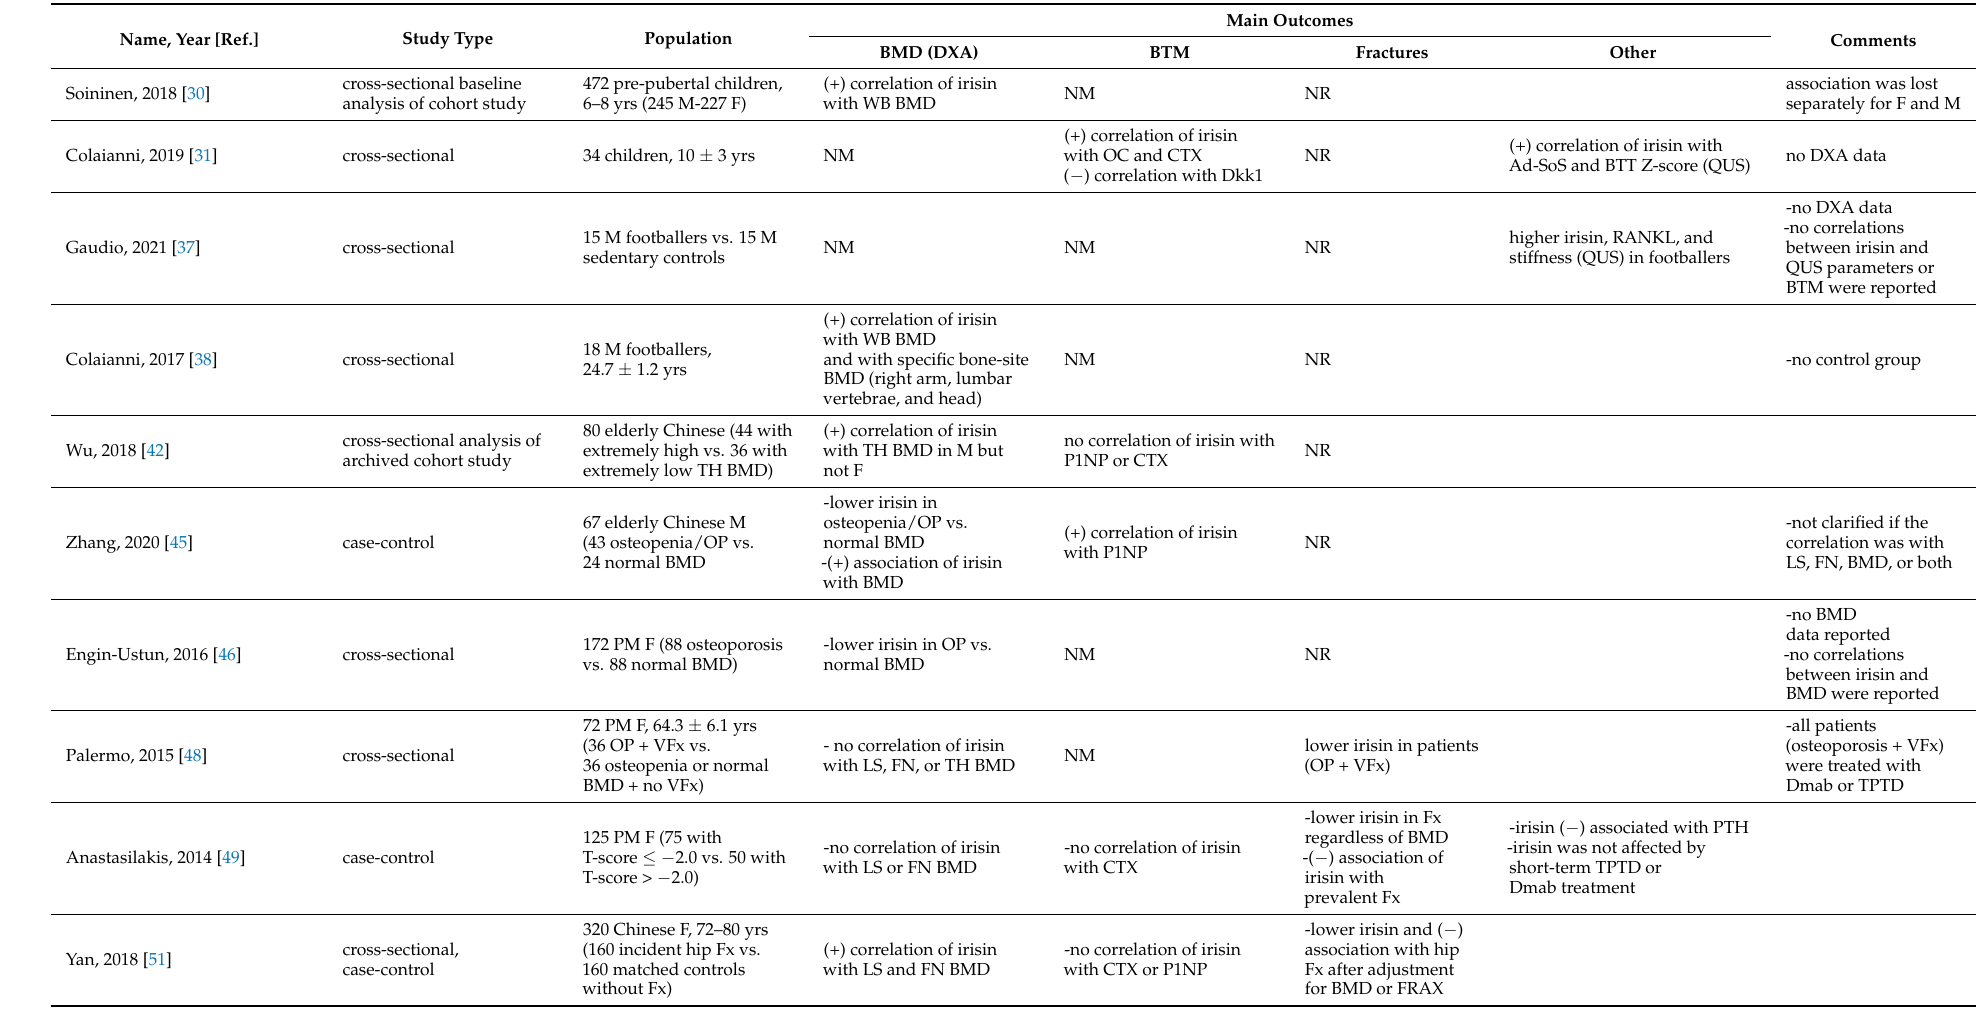
Table 1. Human studies evaluating associations of irisin with bone